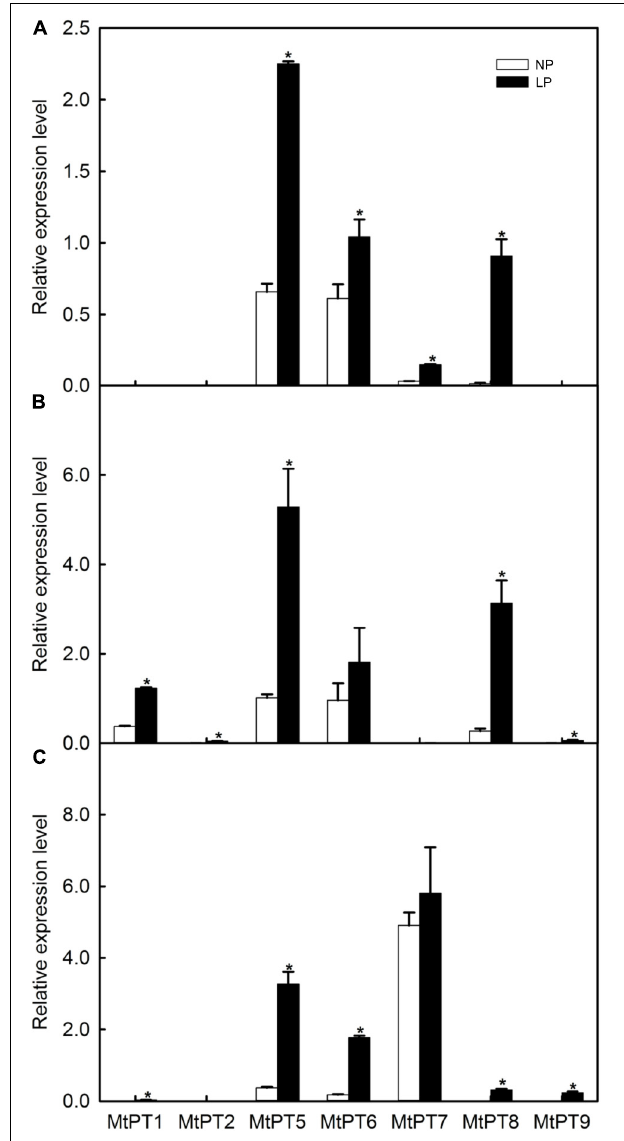
FIGURE 2 | Effect of low phosphate treatments on the expression levels of PHT1 family genes in different tissues of Medicago truncatula . (A) Shoot; (B) Root; (C) Nodule. Relative expression of all genes in different tissues was normalized by the expression level of MtPT5 in roots. NP, normal inorganic phosphate (Pi) concentration (260 µ M); LP, low Pi concentration treatment (5 µ M). Bars represent the mean ± SE ( n = 3). Asterisks represent significant differences between NP and LP: * P <